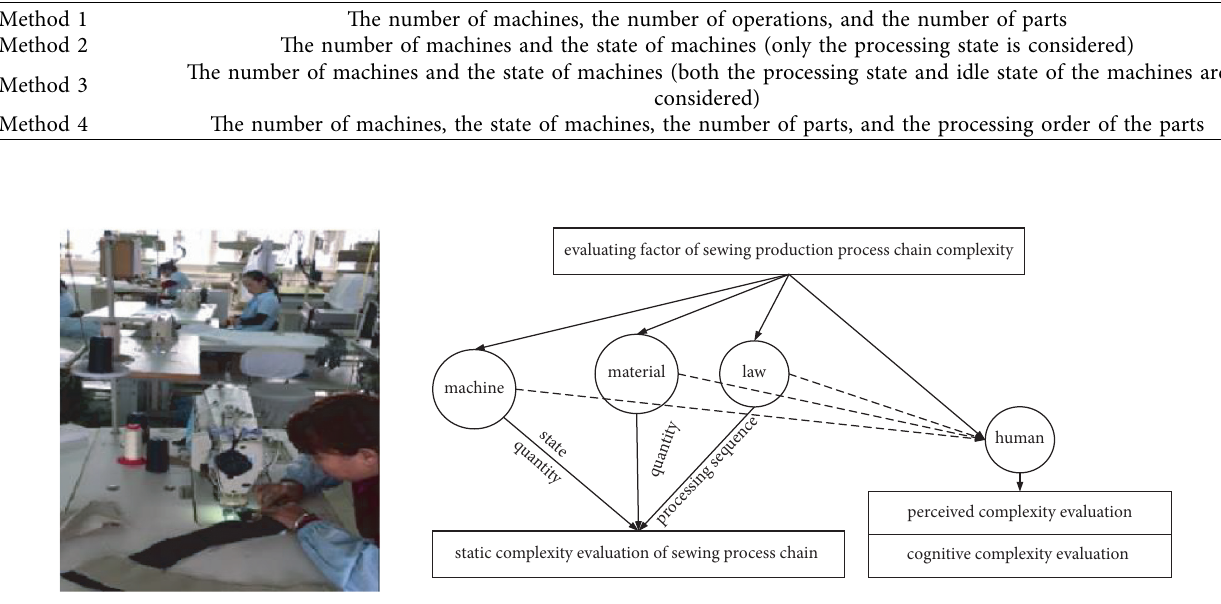
Figure 2: Evaluation framework of sewing process chain complexity.